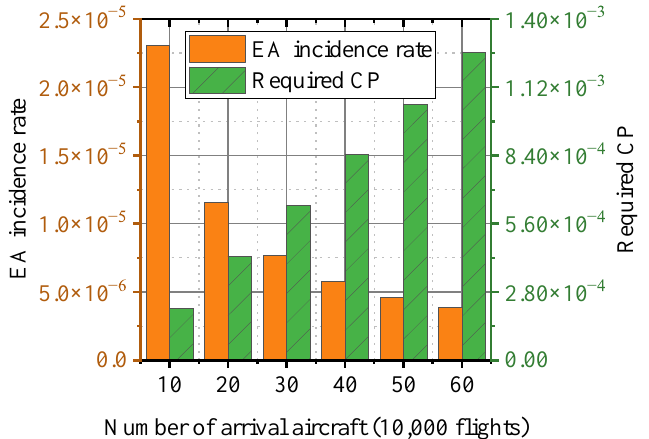
Figure 11. The relationship between the number of arrival aircraft, the EA incidence rate and the required CP (90%